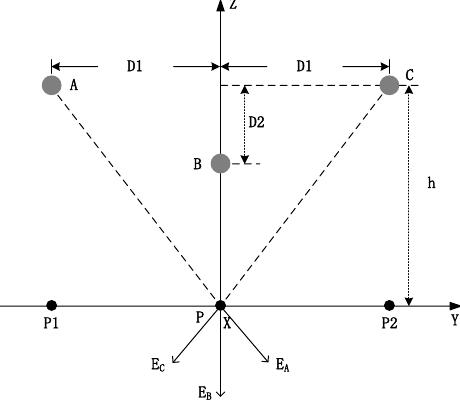
Figure 22. Triangular arrangement of a three-phase wire.